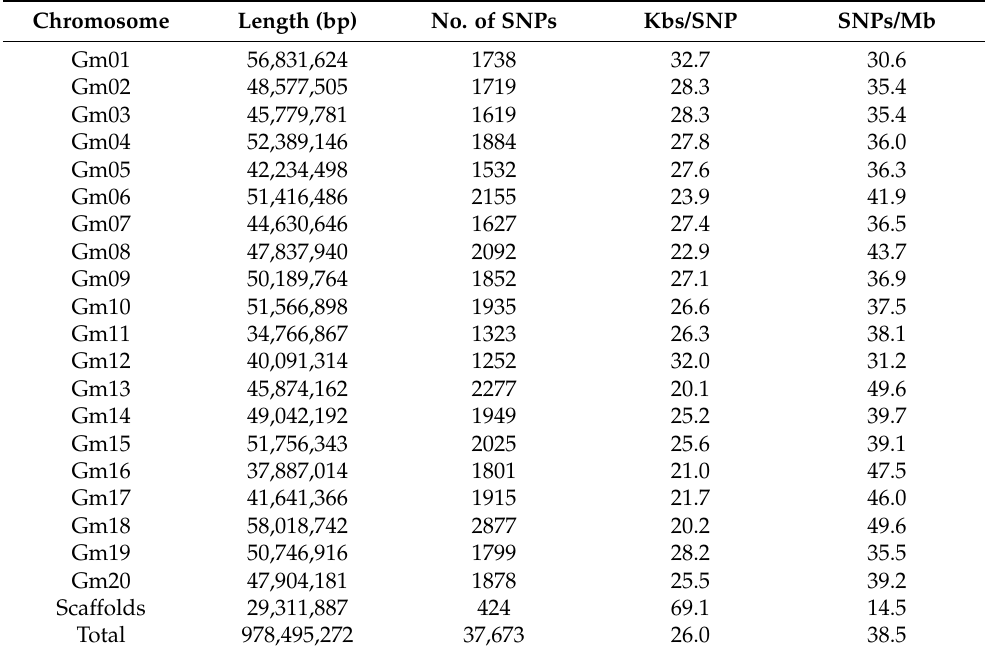
Table 1. Chromosomal distribution and frequency of SNPs identified using the GBS approach in 192 soybean MDP